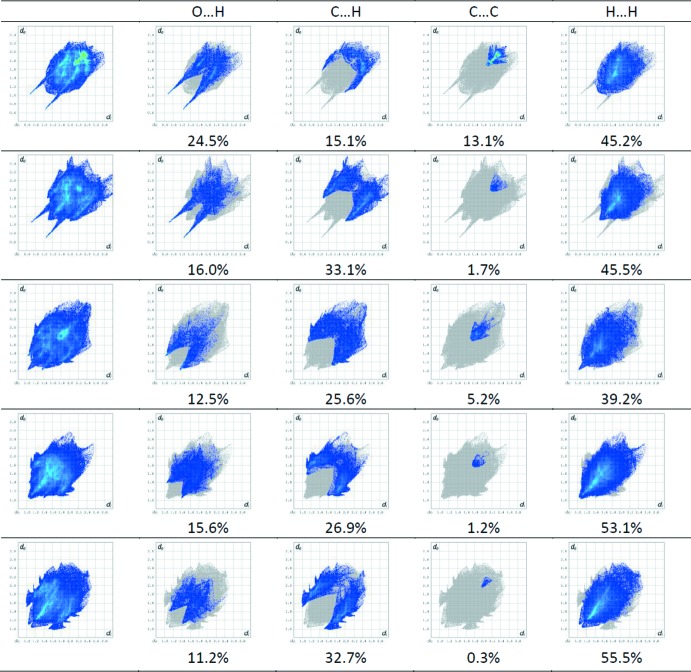
Fingerprint plots of the title compounds; full Hirshfeld surface (left) and delineated into H⋯O, H⋯C, C⋯C, and H⋯H contacts, showing the percentage contributions of the contacts to the total Hirshfeld surface area of the mol­ecules. First row: compound I; second row: compound II; third row: 3-(4-chloro­benzyl­idene)-2-phenyl-2,3-di­hydro-4H-chromen-4-one (Kupcewicz et al., 2013 ▸); fourth row: (E)-3-(4-N,N-di­ethyl­amino­benzyl­idene)chroman-4-one (Adamus-Grabicka et al., 2018 ▸); fifth row: (E)-3-(4-N,N-di­ethyl­amino­benzyl­idene)-2-phenyl­chroman-4-one (Adamus-Grabicka et al., 2018 ▸).